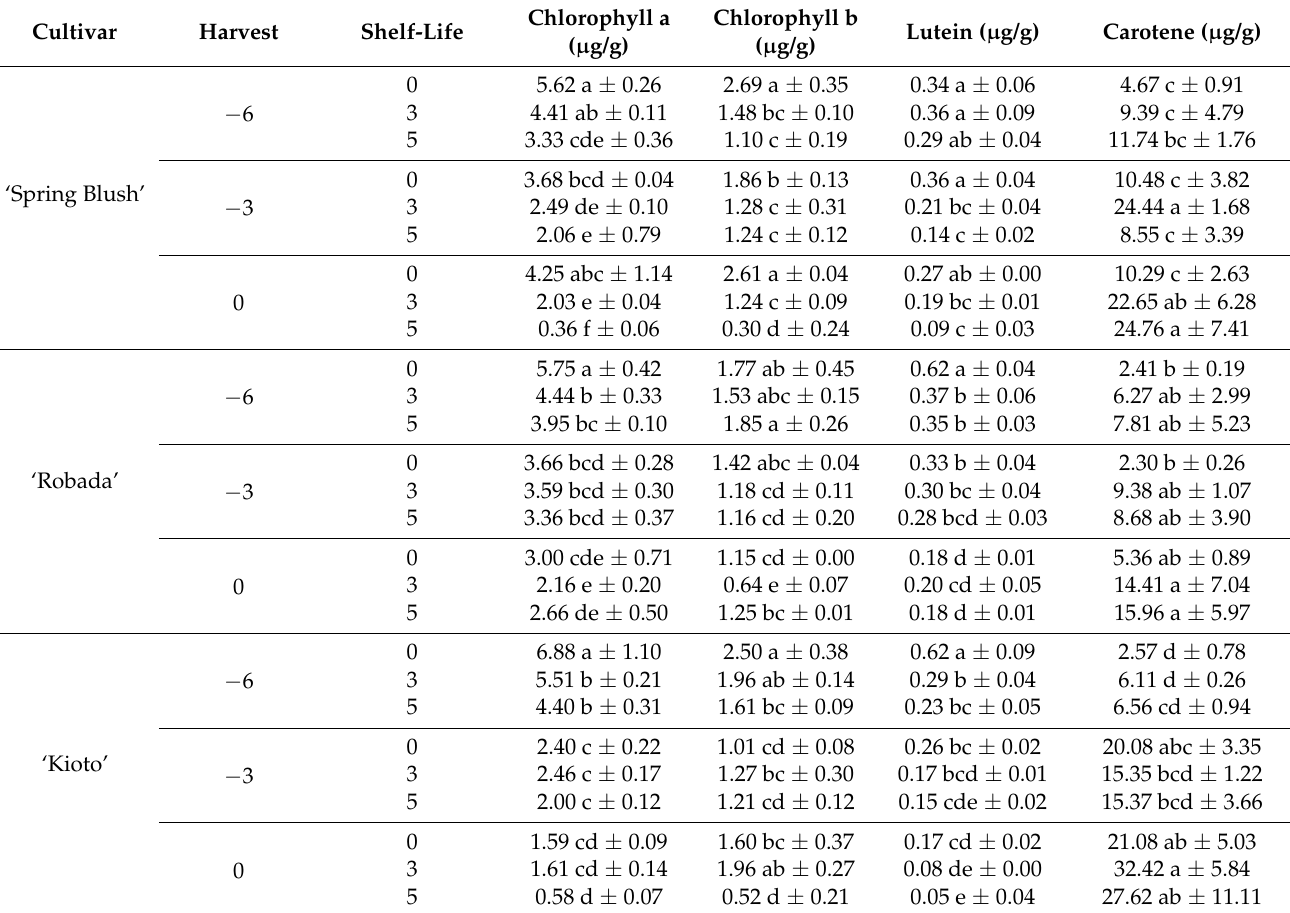
Table 3. Individual pigment evolution in apricot at harvest and during shelf-life. Cultivar